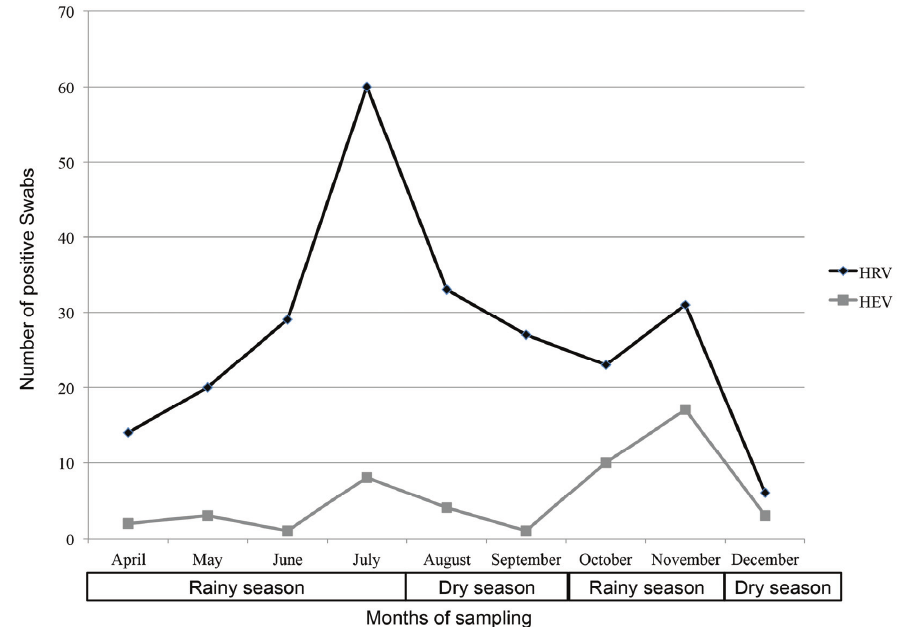
Figure 2. Repartition of positive swabs for human rhinoviruses (HRV) and enteroviruses (HEV) according to months of sampling.